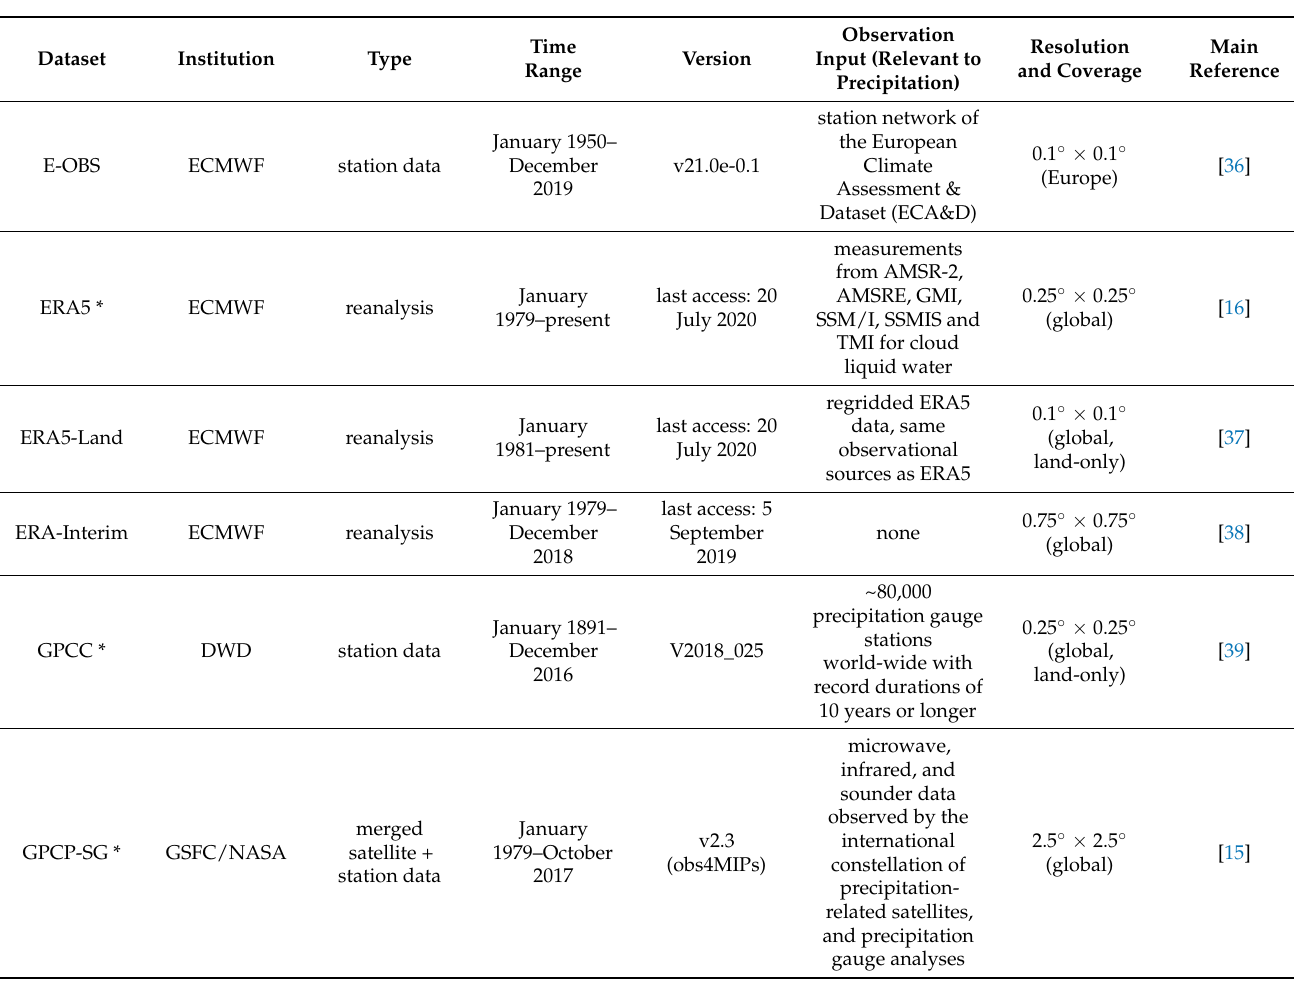
Table 1. Summary of all analyzed datasets of total precipitation. Datasets that have been used in [34] for the analysis and evaluation of CMIP6 climate models are marked with an asterisk. All datasets have been used with a monthly time